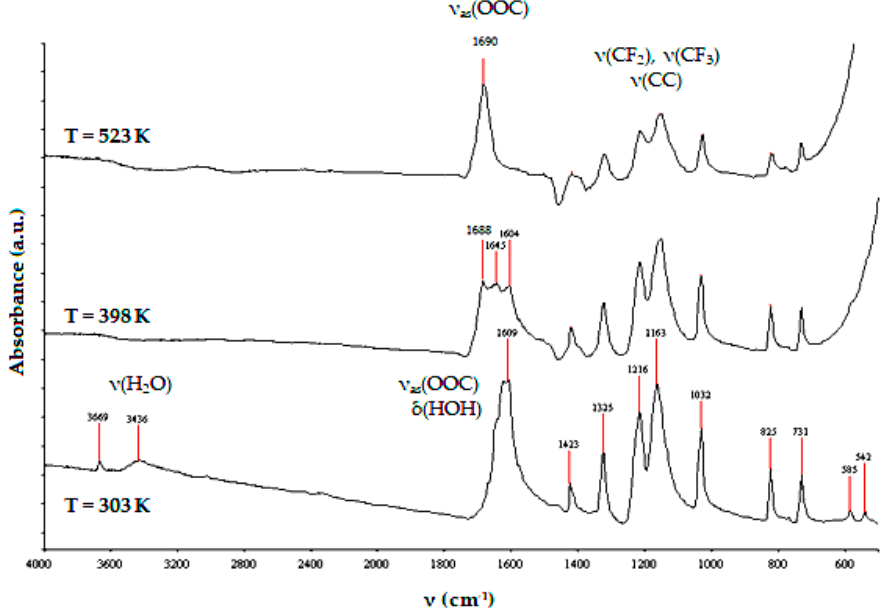
Figure 2. IR spectra of [Ag 5 (O 2 CC 2 F 5 ) 5 (H 2 O) 3 ] registered at 303, 398, and 523 K.